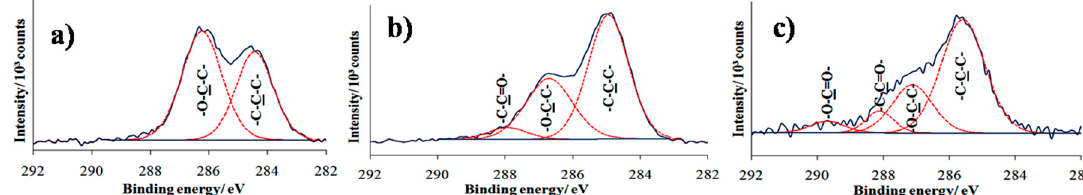
Figure 5. High resolution of C 1s XPS spectra of ( a ) PEG silane monolayer formation; ( b ) PEG silane monolayer being exposed to UV; and ( c ) 2-amino-1,1,1-trifluoroethane (TFEA) test on UV modified surfaces.